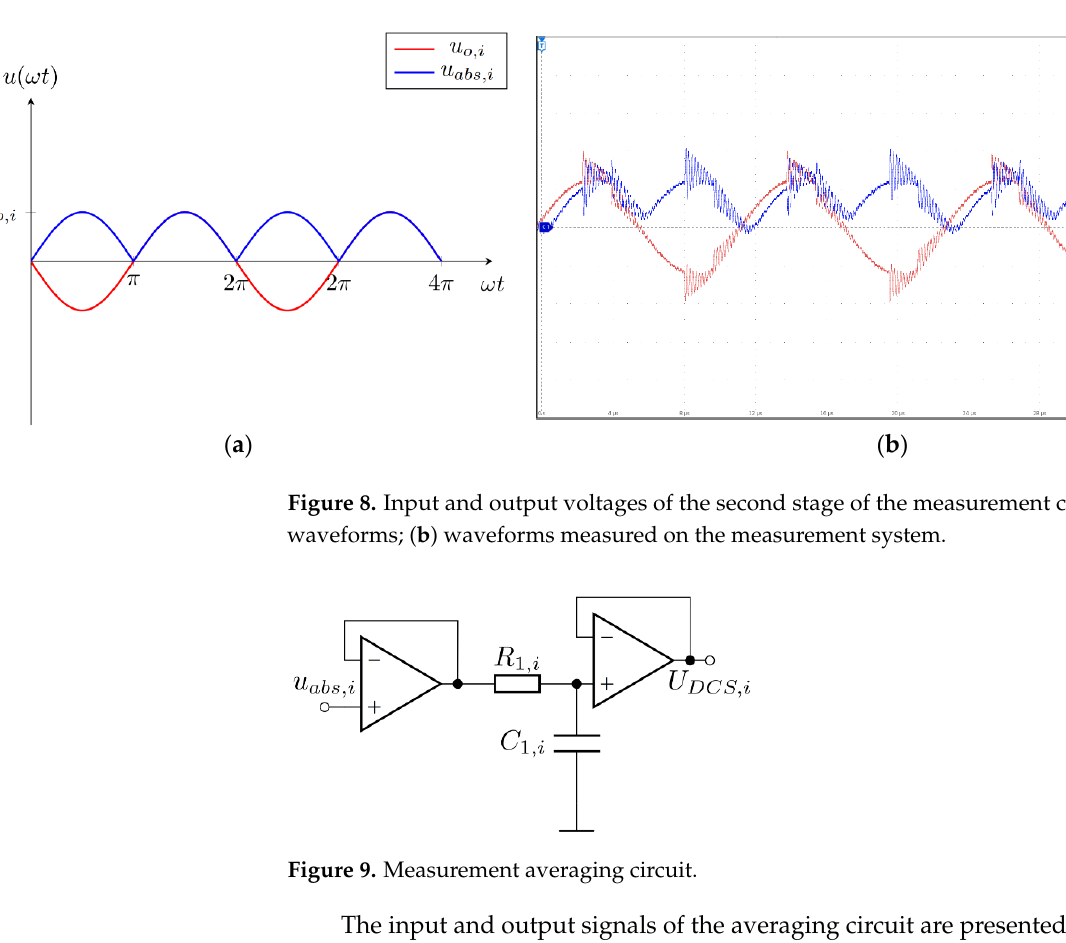
Figure 9. Measurement averaging circuit.